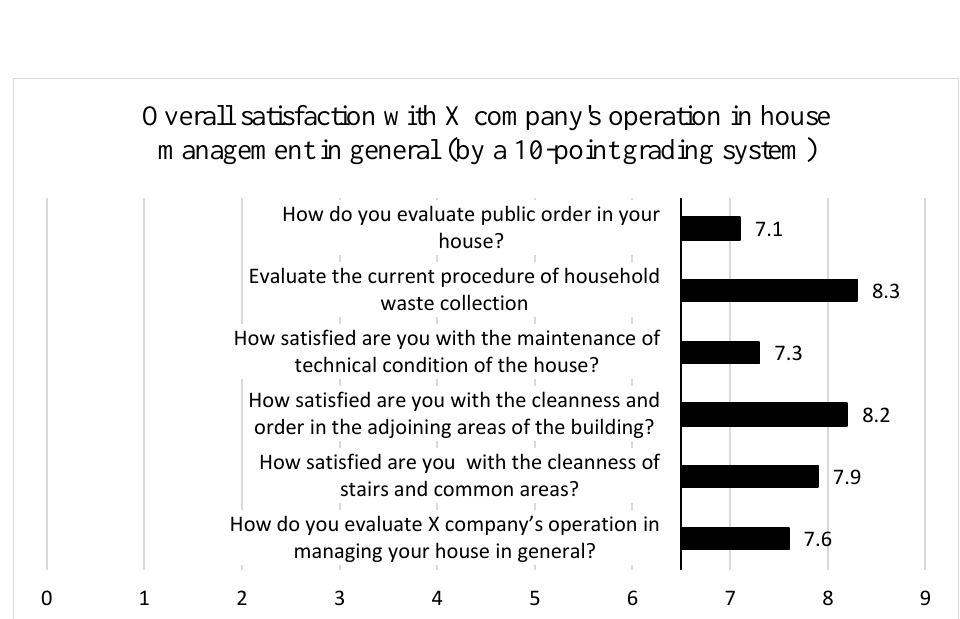
Fig. 3. Overall satisfaction with the company operation in house